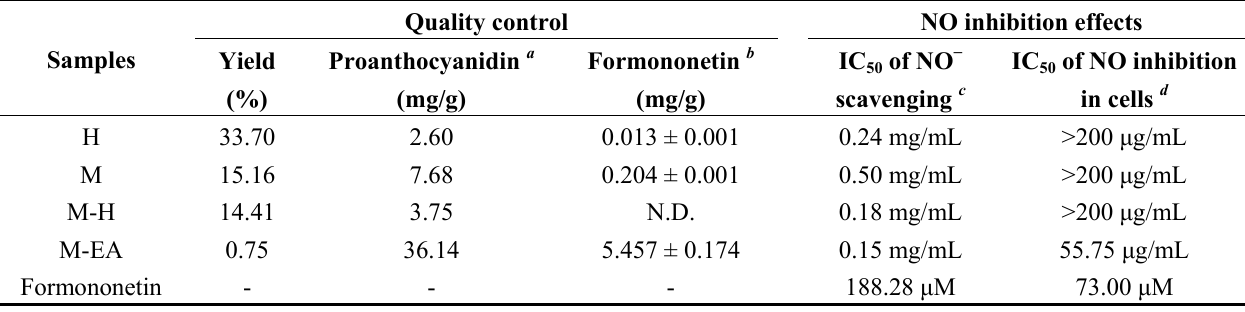
Table 1. Quality control and NO inhibitory effects of Hedysarum polybotrys extracts and its substance marker,